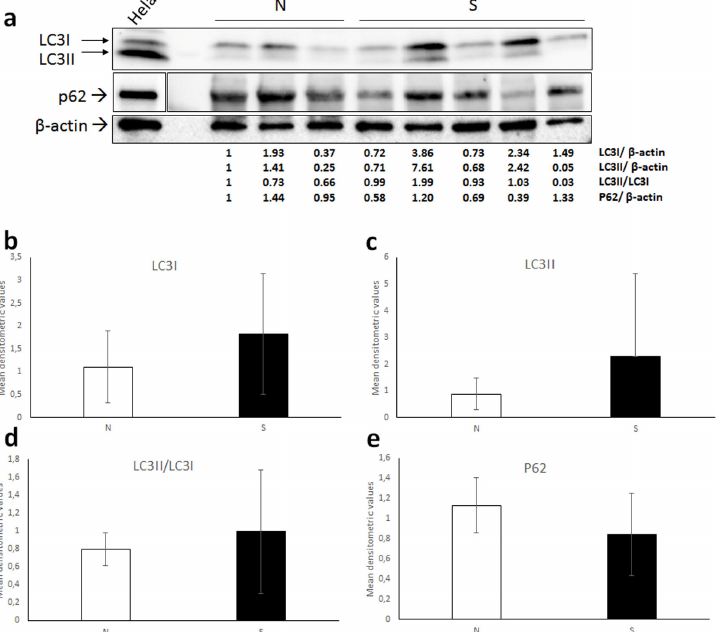
Figure 4. ( a ) Western blot analysis for LC3 and P62 in normal skin samples (N) and equine sarcoids. Cell lysate from Hela cell line was run on the gel to demonstrate the specificity of the antibodies. For P62 blot, boxes are cut from the same membrane at different exposure times and properly aligned according to the molecular weight loaded onto the gel (see Supplementary Materials). Fol- lowing stripping of the membrane, anti β -actin antibody was applied in order to allow normaliza- tion. Densitometric ratios LC3I/ β -actin, LC3II/ β -actin, LC3II/ LC3I and P62/ β -actin for each normal and sarcoid sample are indicated. ( b – e ) Mean densitometric values+/ − standard deviations of N vs. S group.